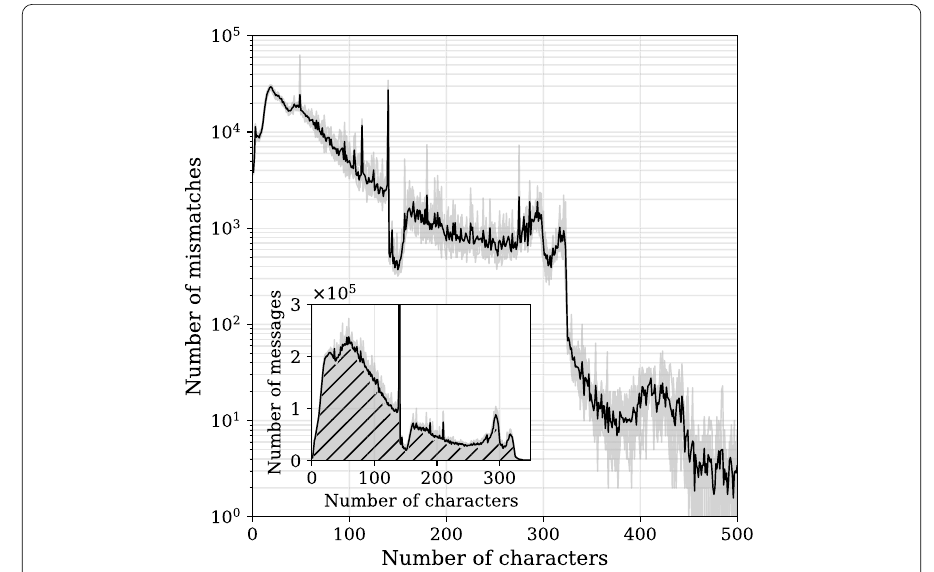
Figure 11 Language identification uncertainty as a function of tweet-length for top 10 most used languages on Twitter. We display the number of messages that were classified differently by Twitter-LID model and FastText-LID for the top-10 prominent languages as a function of the number of characters in each message. Unlike Twitter, we count each character individually, which is why the length of each message may exceed the 280 character limit. The grey lines indicate the daily number of mismatches between 2020-01-01 and 2020-01-07 (approximately 32 million messages for each day for the top-10 used languages), whereas the black line shows an average of that whole week